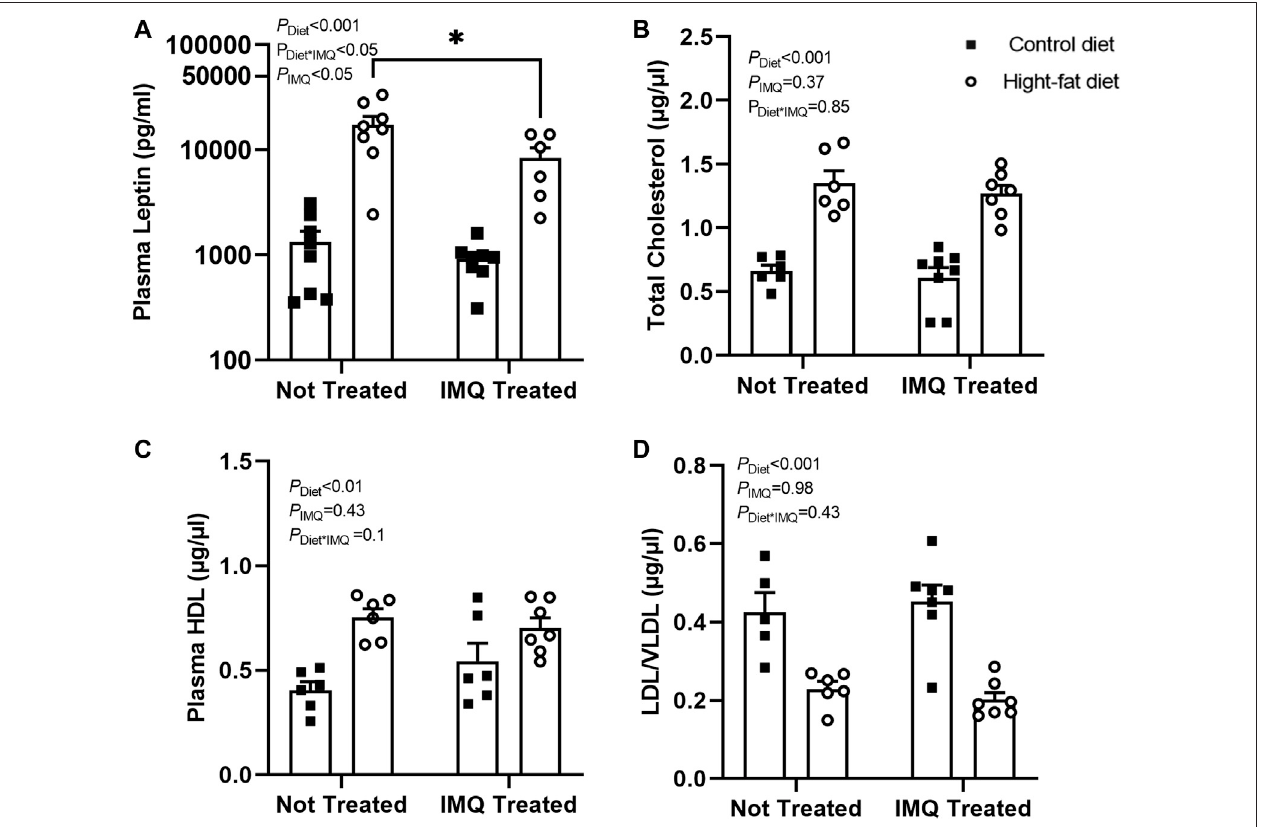
FIGURE3| Imiquimodattenuates plasma leptinincreasesbut does notaffect diet-induced changesin cholesterol levels. (A) High-fat dietincreasedplasmaleptin, although this effect was attenuated by IMQ (* p < 0.05). (B) Total cholesterol and (C) HDL cholesterol was increased by high-fat diet with no signi fi cant effect of IMQ. (D) High-fatdietmicehadlowerLDL/VLDLcompared tocontroldietmice,buttherewasnoeffectofIMQ.Statisticalcomparisons areindicatedin Figure1 .Dataareshown for n = 6-8 per group due to insuf fi cient plasma available for some